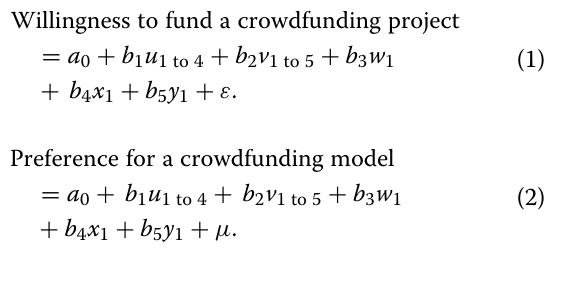
‘Std. Dev’ is standard deviation. ‘Min.’ is minimum and ‘Max.’ is maximum